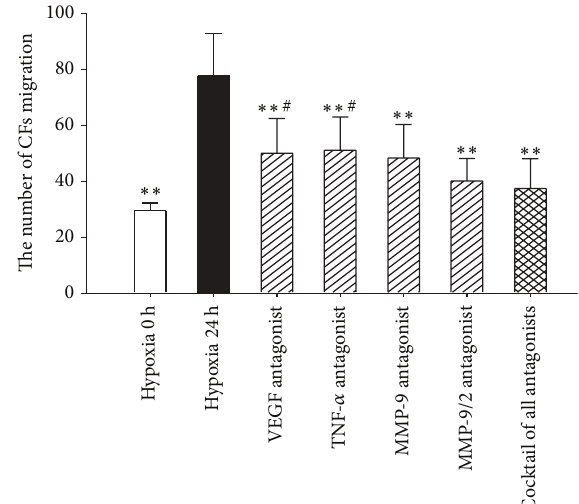
Figure 7: CSCs migration number after adding antagonists. Each of these factors partly participated in the migration process. Compared to the group that was added with cocktail antagonist against all four factors, the number of migration cells in the group that was added with MMP-9 antagonist and MMP-9/2 antagonist shows no significant difference. Results were shown as the mean ± SD values. Experiments were repeated three times. ∗ indicates 𝑃 < 0.05 compared to the hypoxia 24 h group. ∗∗ indicates 𝑃 < 0.01 compared to the hypoxia 24 h group. # indicates 𝑃 < 0.05 compared to the group added with the cocktail of all antagonists. ## indicates 𝑃 < 0.01 compared to the group added with the cocktail of all